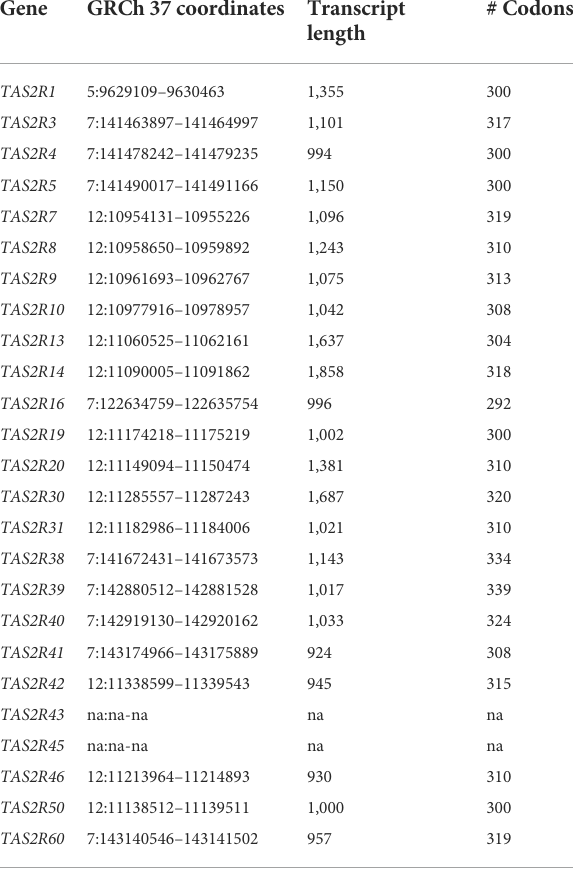
TABLE 2 TAS2R genes, coordinates, and